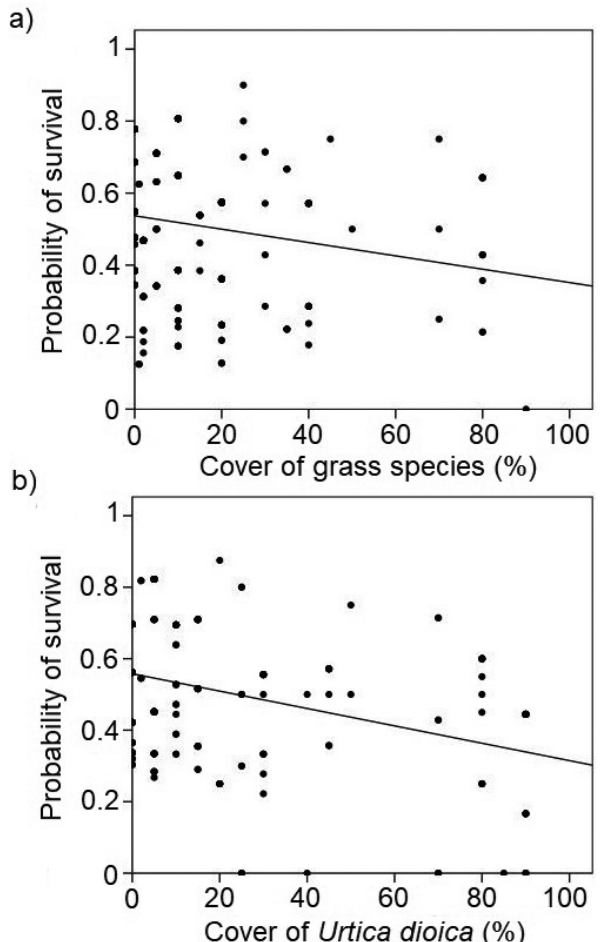
Figure 4. The effects of a cover of grass species and b cover of Urtica dioica on E. lobata seedling and young plant survival